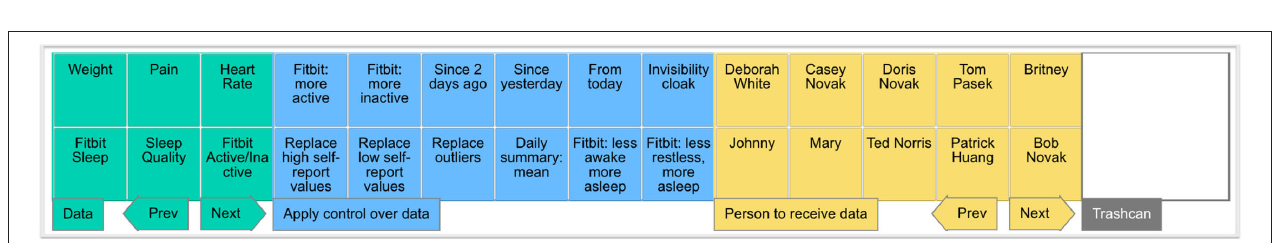
FIGURE 3 | Essential elements in DC: On the left are blocks that represent different data sources (e.g., Heart Rate and Sleep Quality). On the right are yellow blocks that represent different people (e.g., Johnny and Doris Novak) with whom to share data. In the middle are blue blocks that represent different controls (e.g., Daily Summary) that can tailor the details being